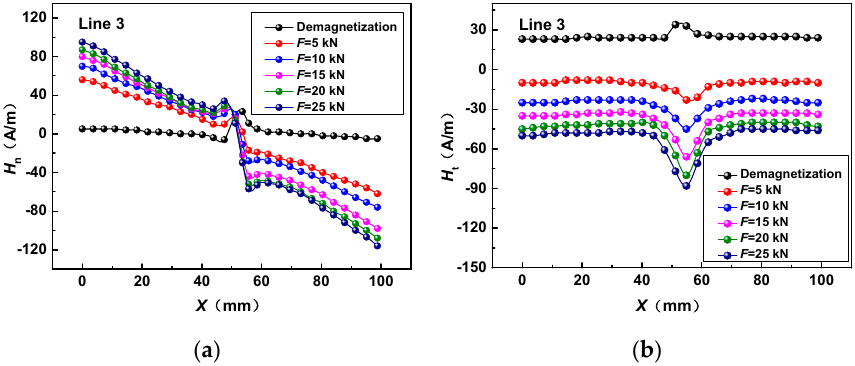
Figure 5. MFL signals distributions of normal and tangential components during experiment 1 (static tension) at different loads measured on Line 3 ( a ) and ( b ), respectively.